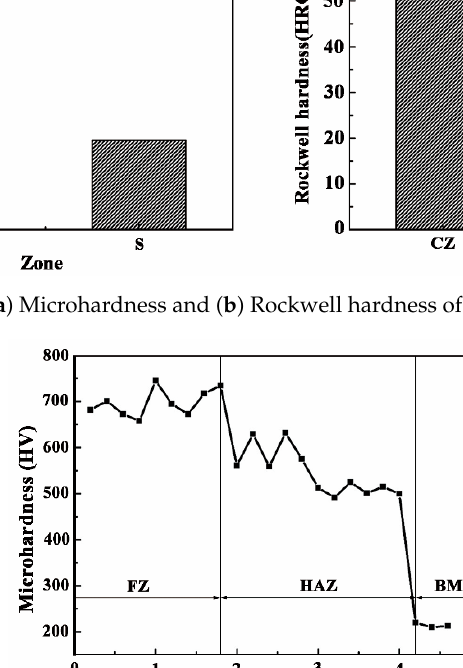
Figure 10. The distribution of microhardness along the depth direction.